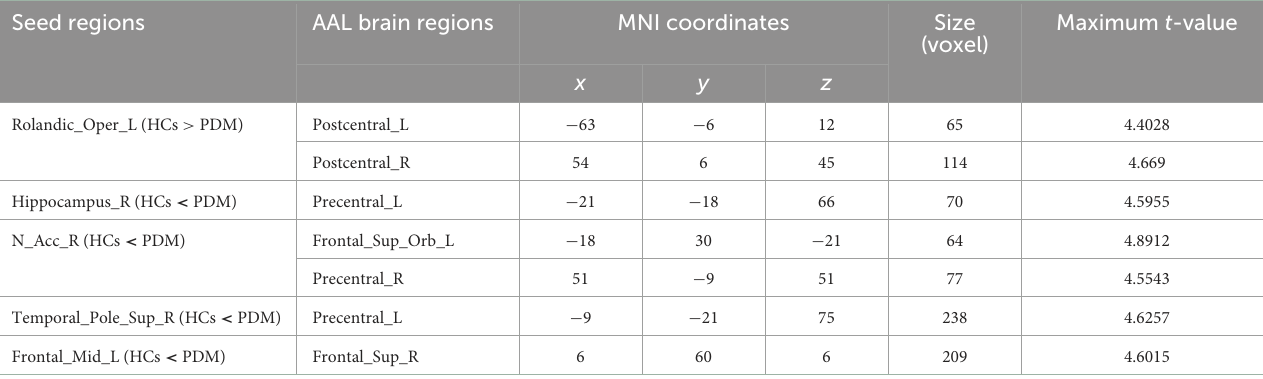
TABLE 4 Regions showing functional connectivity differences between patients with PDM and HCs (voxel threshold: uncorr. p < 0.001, cluster threshold: p -FWE < 0.05). Seed